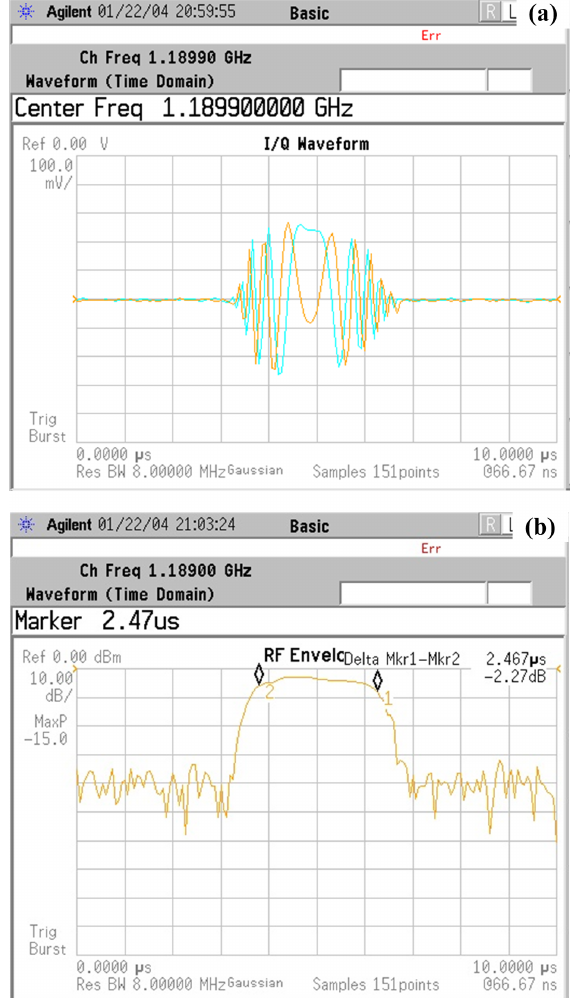
Figure 7. Waveform of the first chirped pulse. ( a ) I/Q waveform. ( b ) RF